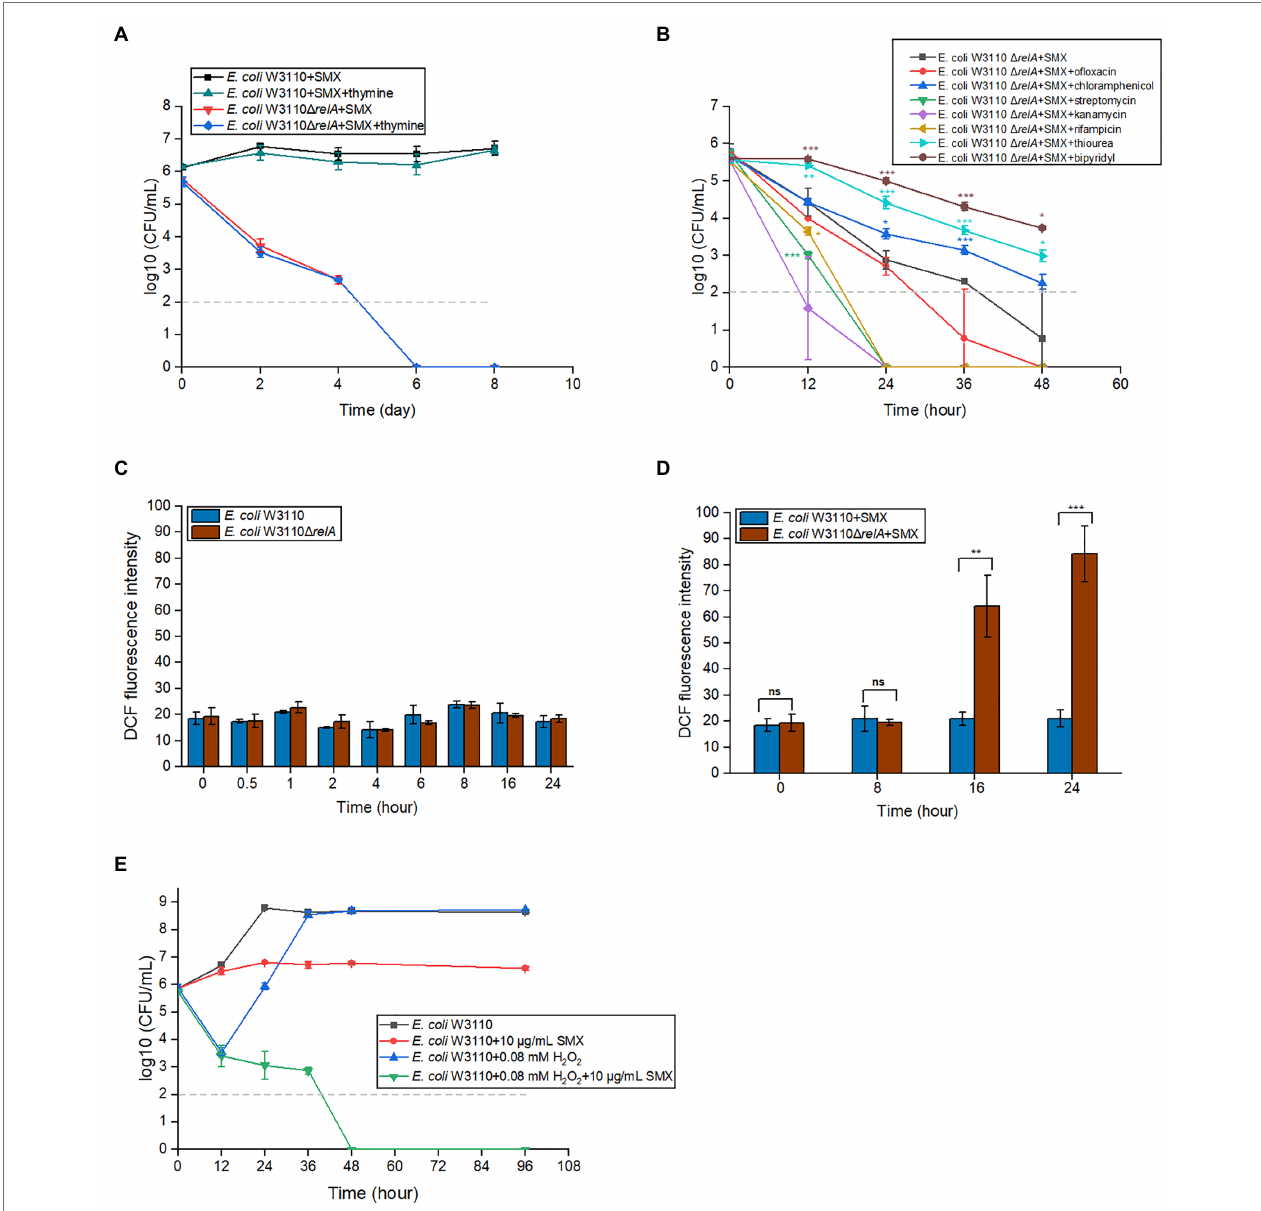
FIGURE 2 | Accumulated ROS, rather than thymine, is responsible for the bactericidal effects of SMX against the Δ relA mutant. (A) Thymine availability was not related to the killing effect of SMX (10 μ g/ml) on the wild type or ∆ relA mutant. The concentration of thymine was 20 μ g/ml. (B) Effects of seven chemical compounds related with ppGpp functions on the killing effect of SMX (10 μ g/ml). ROS production in the wild type and Δ relA mutant without (C) or with (D) SMX treatment. DCF fluorescence intensity was normalized against bacterial CFUs. (E) 0.08 mM H 2 O 2 markedly enhances the killing effect of SMX against E. coli W3110. Dashed gray lines represent the limit of detection. Error bars represent the standard deviation. Asterisks indicate statistically significant differences between means as determined by unpaired two-tailed Student’s t test (* p ≤ 0.05, ** p ≤ 0.01, *** p ≤ 0.001; ns, not significant p > 0.05). In panel A , no statistically significant differences between with/ without thymine were detected for either strain at any time point. In panel B , asterisks of the same color as the line indicate the statistical difference between the strain with compound treatment represented by the line and Δ relA with SMX treatment, and p > 0.05 is not shown. In panel C, no statistically significant differences between Δ relA mutant and wild type at the same time point. In panel E, statistical analysis was determined between SMX with/without H 2 O 2 , and p value of each time point is less than